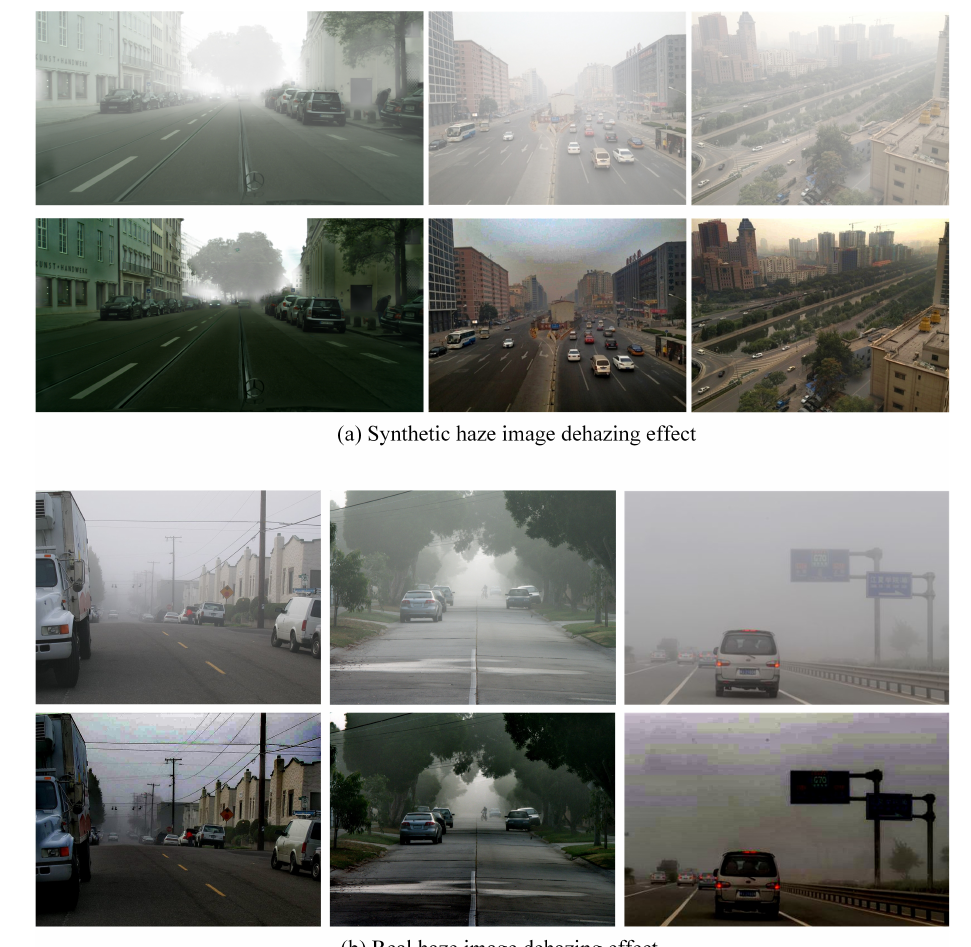
Figure 5. Visual results of dehazing.